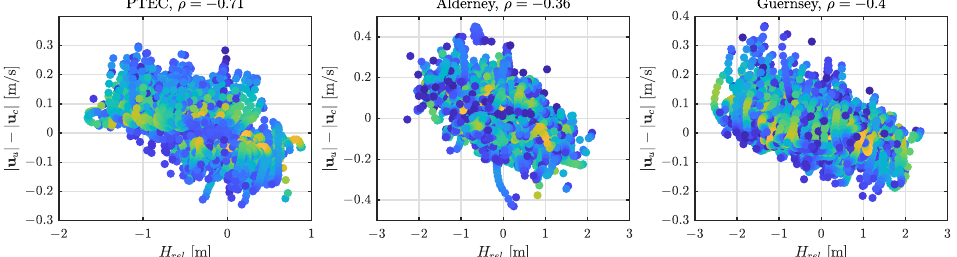
Figure 7. Difference in current speed from uncoupled and coupled models against relative significant wave height. The color of points indicates concurrent current speed from coupled model.